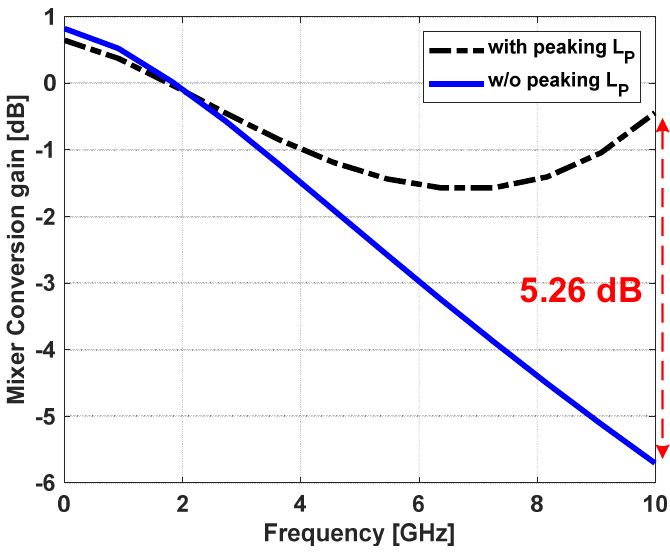
Figure 9. Simulated conversion gain of the down-conversion mixer with and without series peaking inductor L P